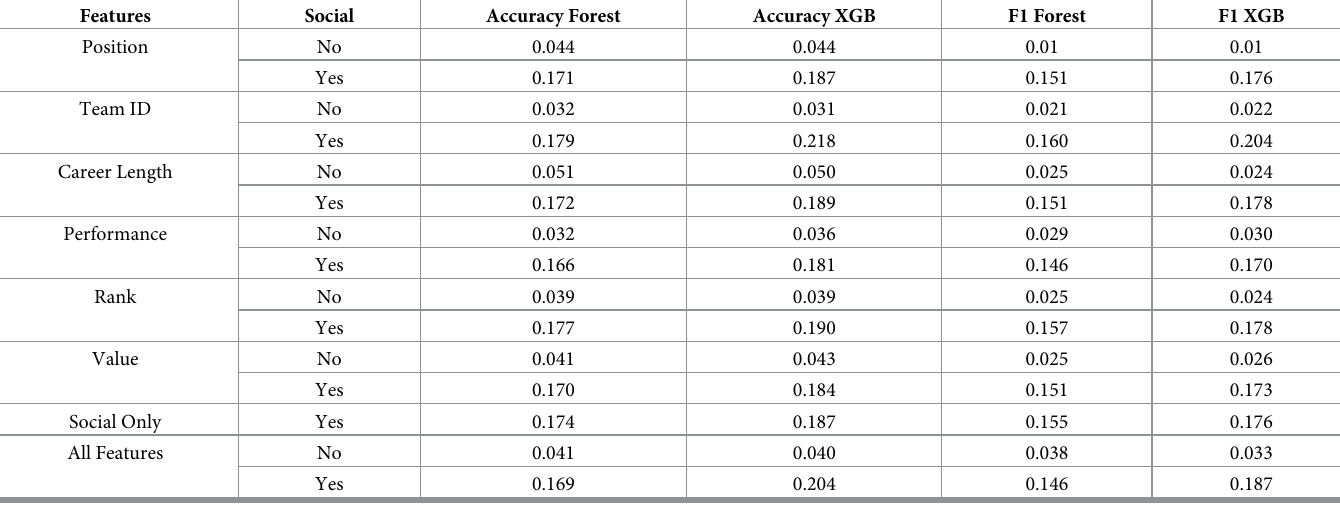
Table 10. Baseball inference results: The inference accuracy and F1 score is shown for team transition in MLB during the time period 2002–2019 for players who had Twitter accounts. Each row indicates which feature(s) were used. We note that a “yes” in the social column means Twitter data was used. Features Social Accuracy Forest Accuracy XGB F1 Forest F1